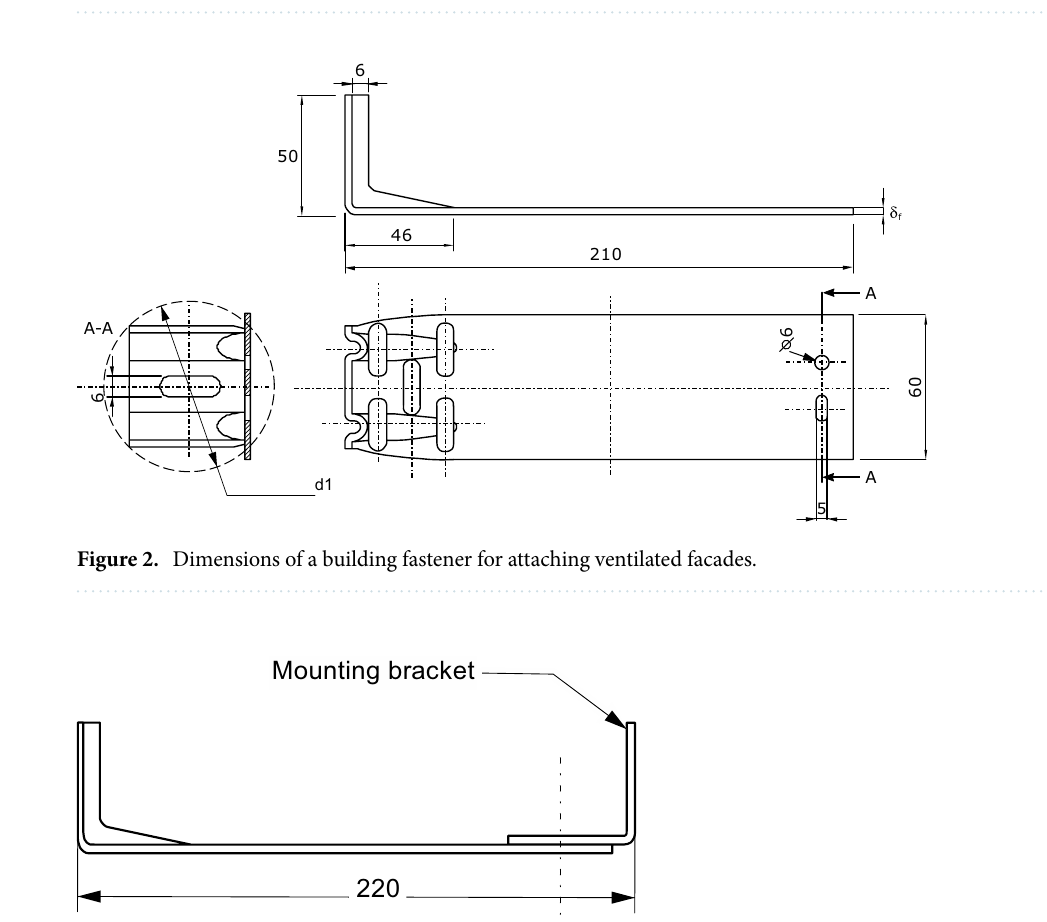
Figure 1. Illustration of the effect of the thermal conductivity of the fastener material and the use of heat flow- impeding openings on the effective conductivity of building fasteners and heat flux transferred. Description: A—heat transfer surface (interface between the fastener and the cooler surface) (m 2 ), L—fastener length in the heat flux direction (m), T h —average temperature of the heater surface (K), T c —average temperature of the cooler surface (K).